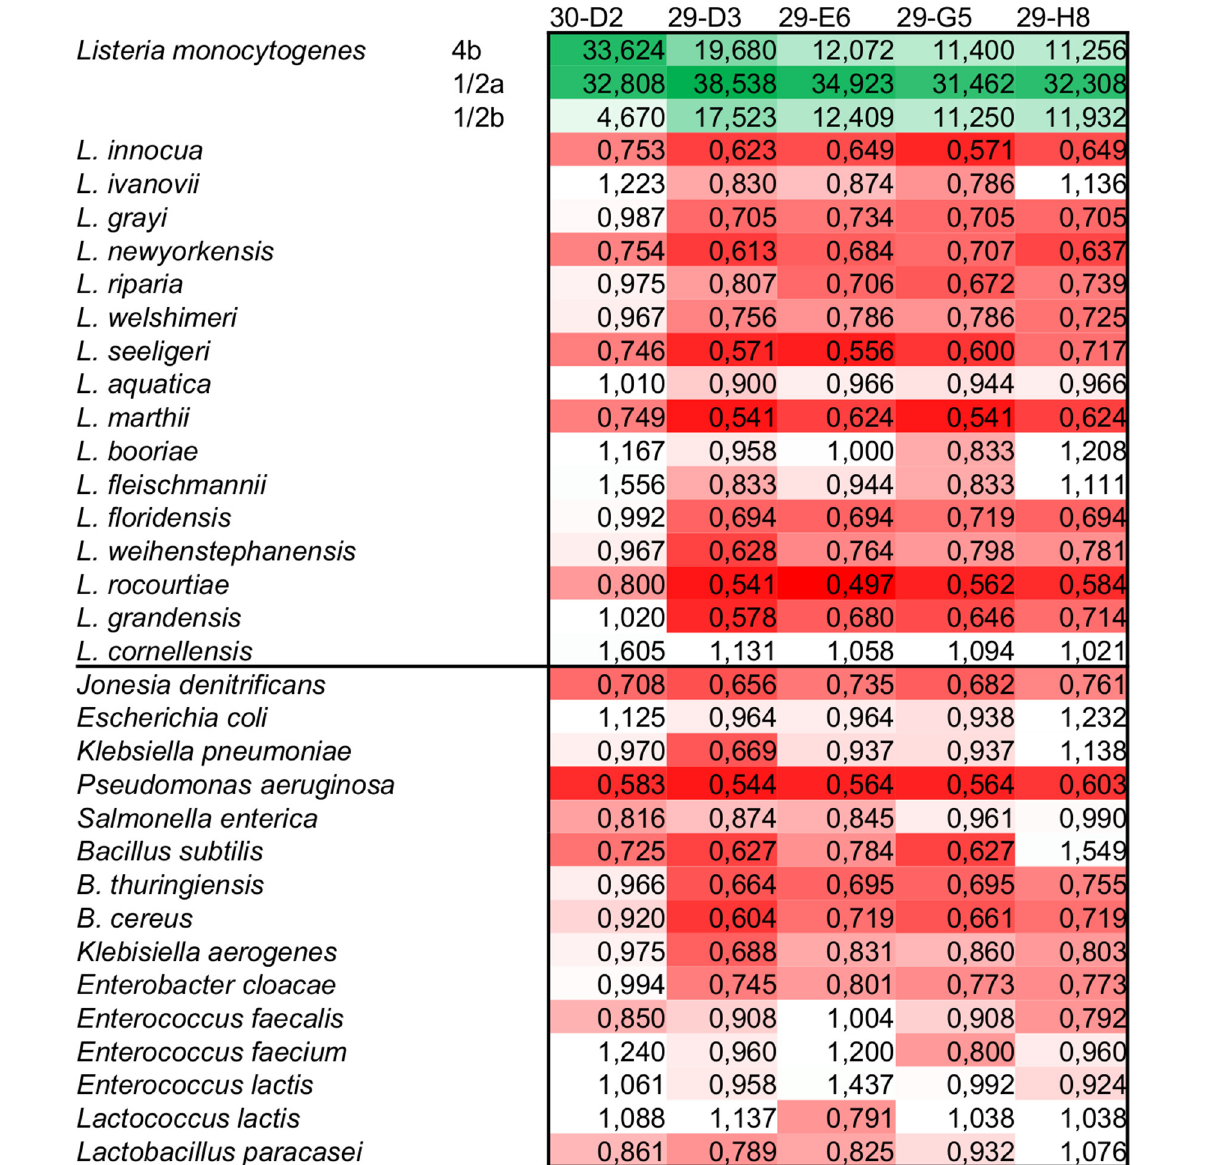
) in indirect ELISA. All five mAbs showed specific reaction against + 1). =